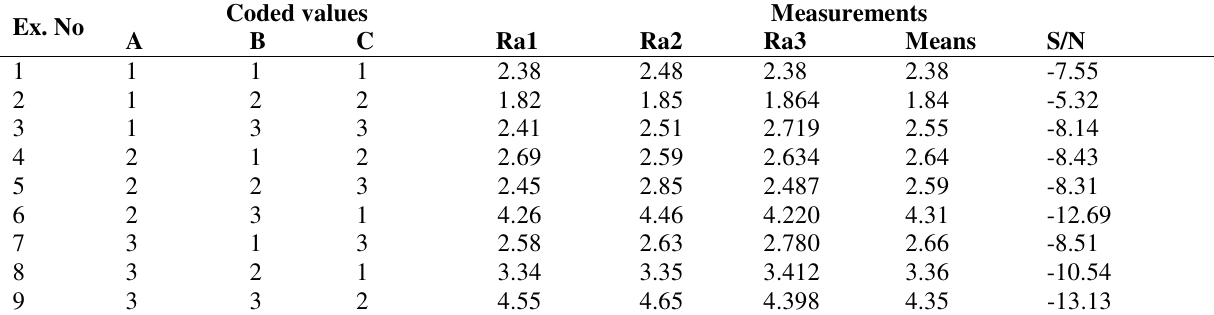
Table 6, Results for